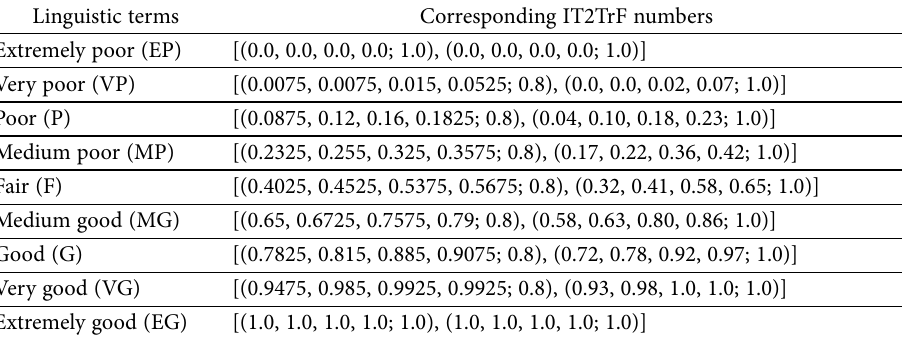
Table 1. Linguistic variables and their corresponding IT2TrF numbers Linguistic